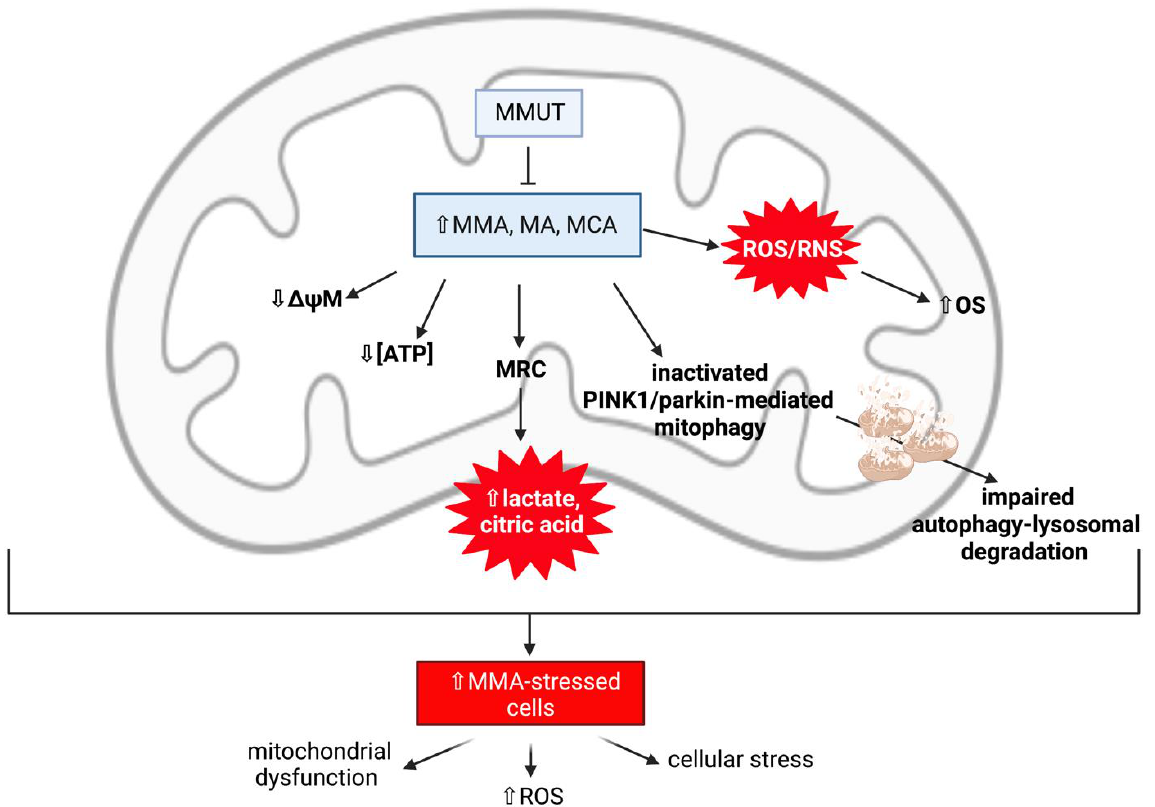
Figure 7. Mechanisms resulting in mitochondrial dysfunction and the development of neurodegeneration due to deficient L-methylmalonyl-CoA mutase activity and the accumulation of methylmalonic acid and secondary metabolites in methylmalonic acidaemia. Mitochondrial accumulation of these toxic organic acids leads to consequences that affect the mitochondrial structure and function such as reduced ∆Ψ m and ATP; impaired MRC function resulting in increases in lactate and citric acid; inactivated PINK1/parkin-mediated mitophagy, resulting in accumulation of damaged mitochon- dria that are not targeted for removal via the autophagy − lysosomal system; and increases in reactive oxygen/nitrogen species causing increased oxidative stress. A combination of these factors results in elevations in the number of methyl- malonic acid-stressed cells, leading to mitochondrial dysfunction and cellular stress, which are factors responsible for the development of neurodegeneration in methylmalonic acidaemia (created using biorender.com). ∆Ψ m—mitochondrial membrane potential; ATP—adenosine triphosphate; MRC—mitochondrial respiratory chain; PINK1—PTEN-induced kinase 1; MMUT—L-methylmalonyl-CoA mutase; MMA—methylmalonic acid; MA—malonic acid; MCA—2-methylcitrate; ROS/RNS—reactive oxygen/nitrogen species; OS—oxidative